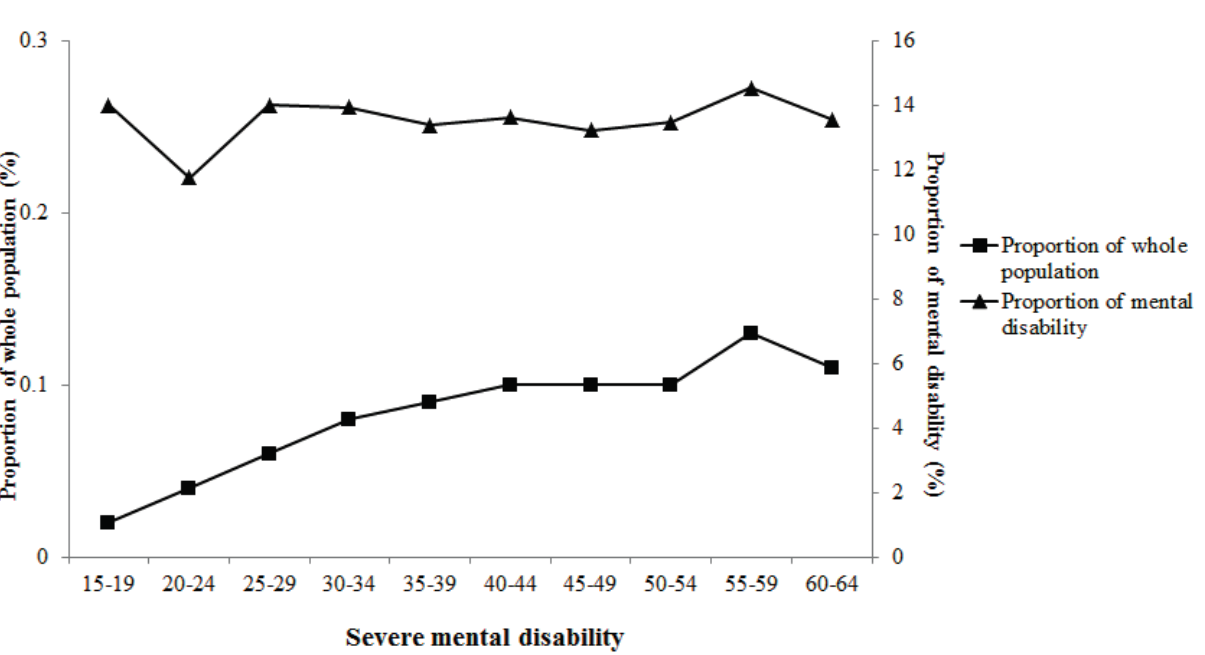
Figure 4. Proportion of moderate mental disability in different age groups.